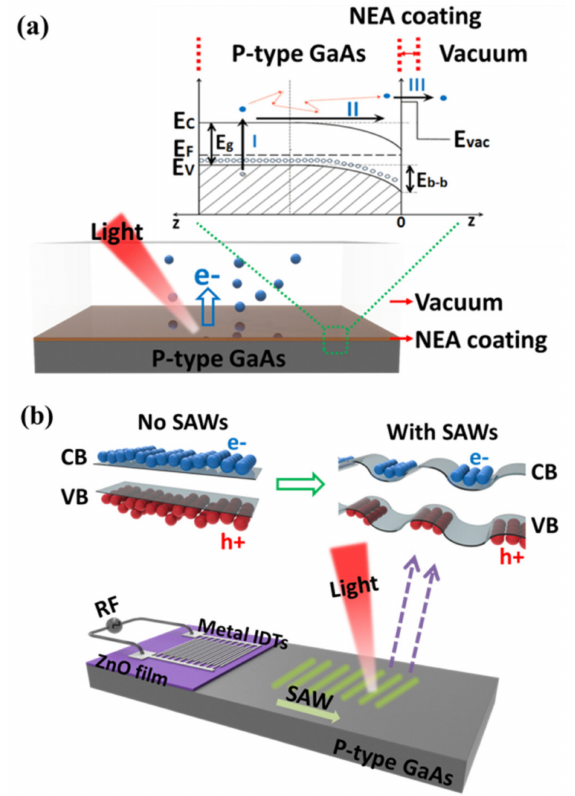
Figure 1. ( a ) The bottom is a three-dimensional (3D) schematic view showing the photoemission from p-type doped GaAs surface with a thin negative electron a ffi nity (NEA) coating. The inset is a band diagram demonstration of the three-step photoemission mechanism: I. photoexcitation, II. transport, III. emission from the surface. ( b ) The 3D schematic view at bottom shows the concept and structure of our surface acoustic wave (SAW) device used to generate SAWs on p-type doped GaAs substrate. Top left—the result of photoexcitation without SAWs. Top right—the band bending e ff ect caused by SAWs. In this case, the electrons and holes are spatially separated, thus the recombination is